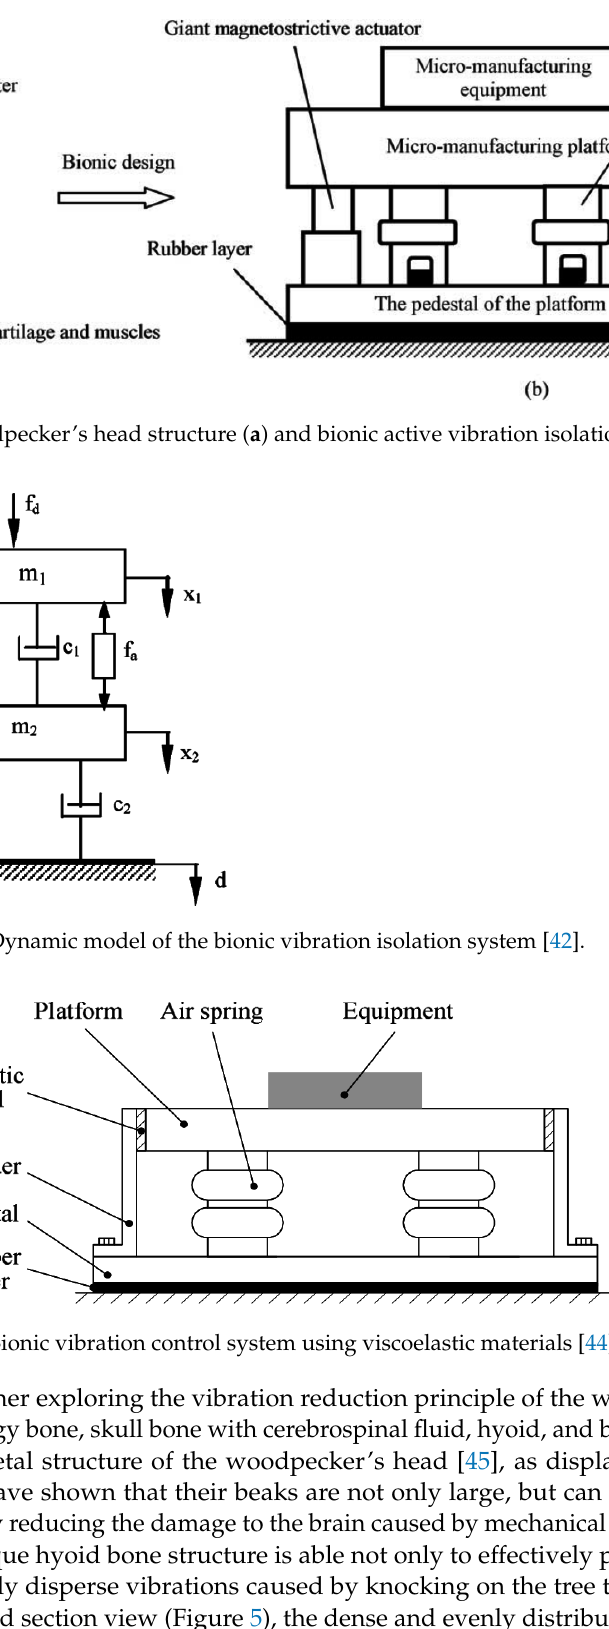
Figure 3. Bionic vibration control system using viscoelastic materials [44].